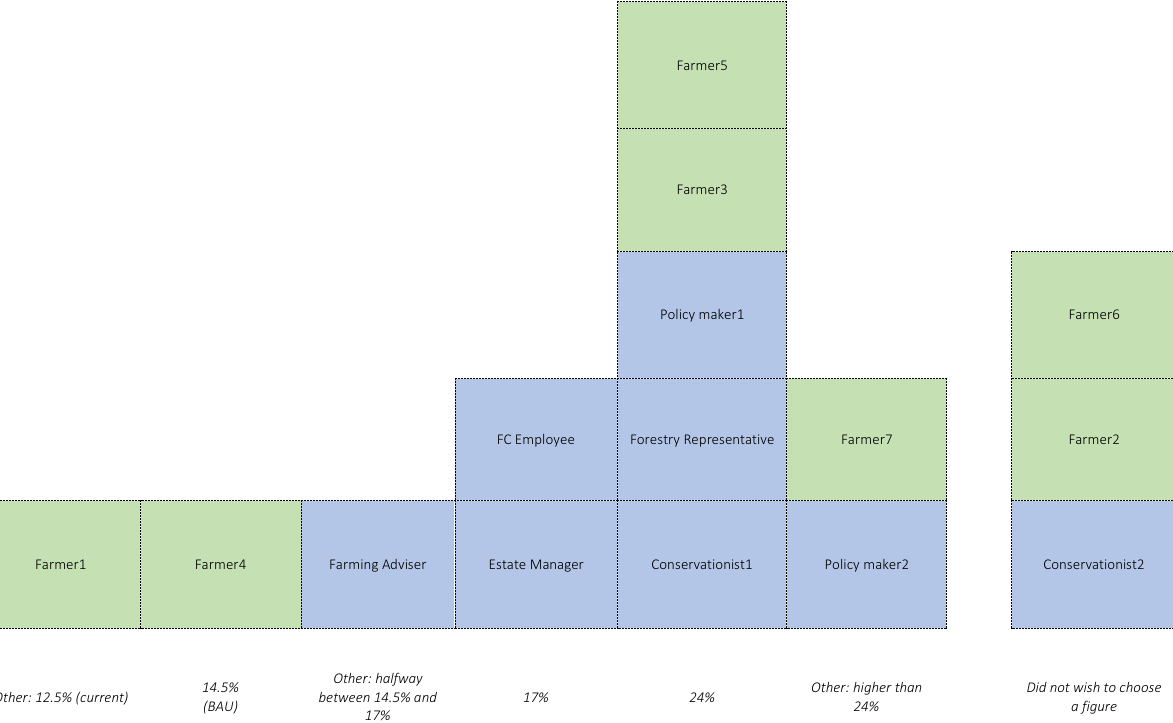
Figure 3. Afforestation scenario selection of the 15 stakeholder participants in semi-structured interview. In blue are key informants and in green are